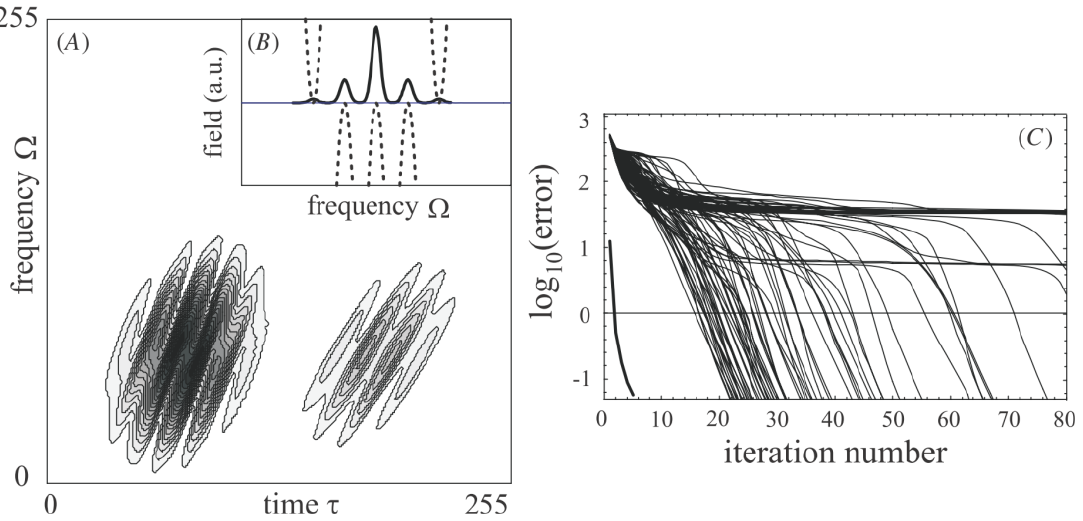
Figure 6. ( A ) Simulated VAMPIRE spectrogram generated with the signal in ( B ) and a filtered signal Gaussian. ( C ) Rate of convergence plots. The plots on the right side show the convergence behavior of principle component generalized projection algorithm (PCGPA) with random initial guesses, and the plot on the lower left corner shows convergence of the VAMPIRE algorithm